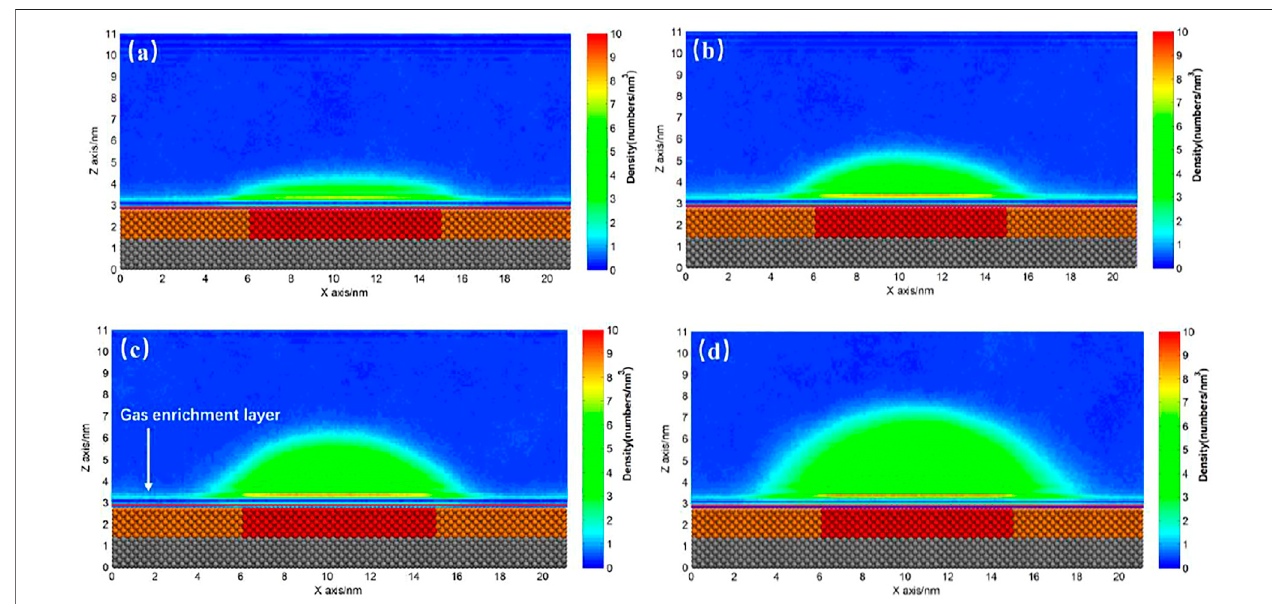
FIGURE 7 | Time-averaged gas density distribution map for S H patterned S M substrate. (A) 400, (B) 500, (C) 600, (D) 800 gas molecules. There are 9,000 liquid molecules in these simulations, and the initial box size is 21.19 × 2.75 × 13.00 nm 3 . The yellow beads represent S M particles, the red beads represent S H particles, and the silver beads represent S L particles.